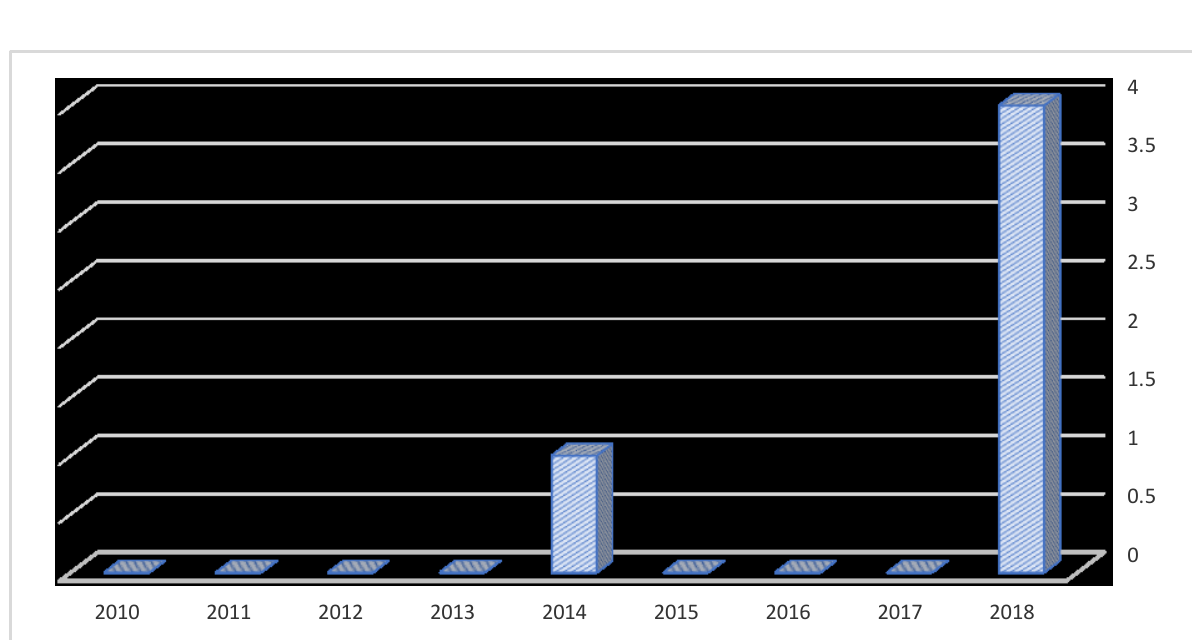
Figure 3 . Timeline of literature on community’s detection in a criminal network within the range